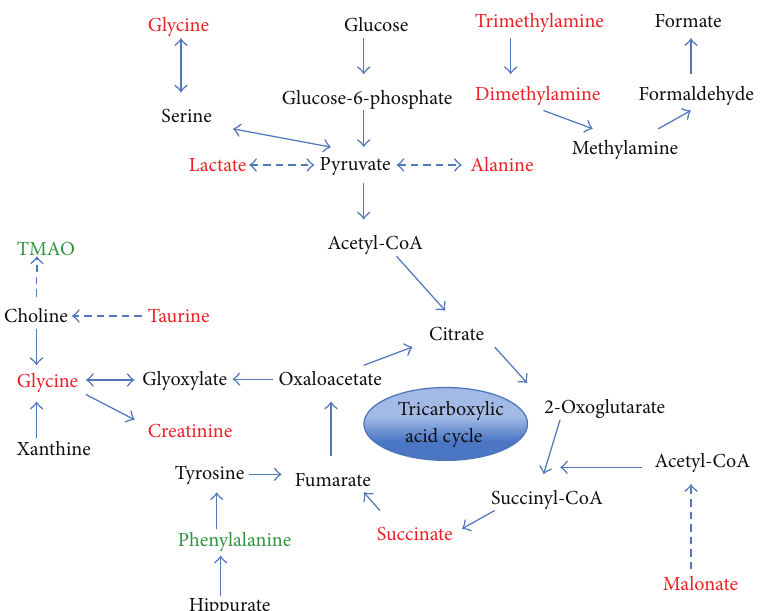
Figure 7: Summary of the metabolic pathways with indication of the effect of first two weeks of training on urine metabolite levels. Color coding: black, no change; red, upregulation; green,